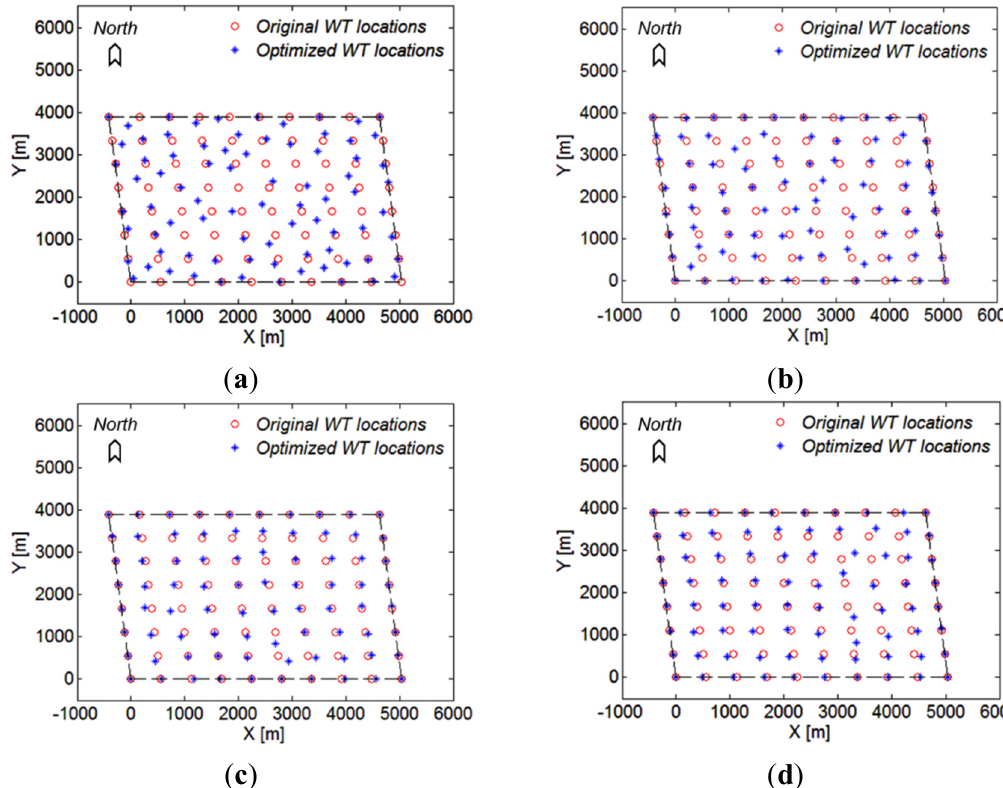
Figure 9. Optimized layouts of the Horns Rev 1 WF by using the spline joint